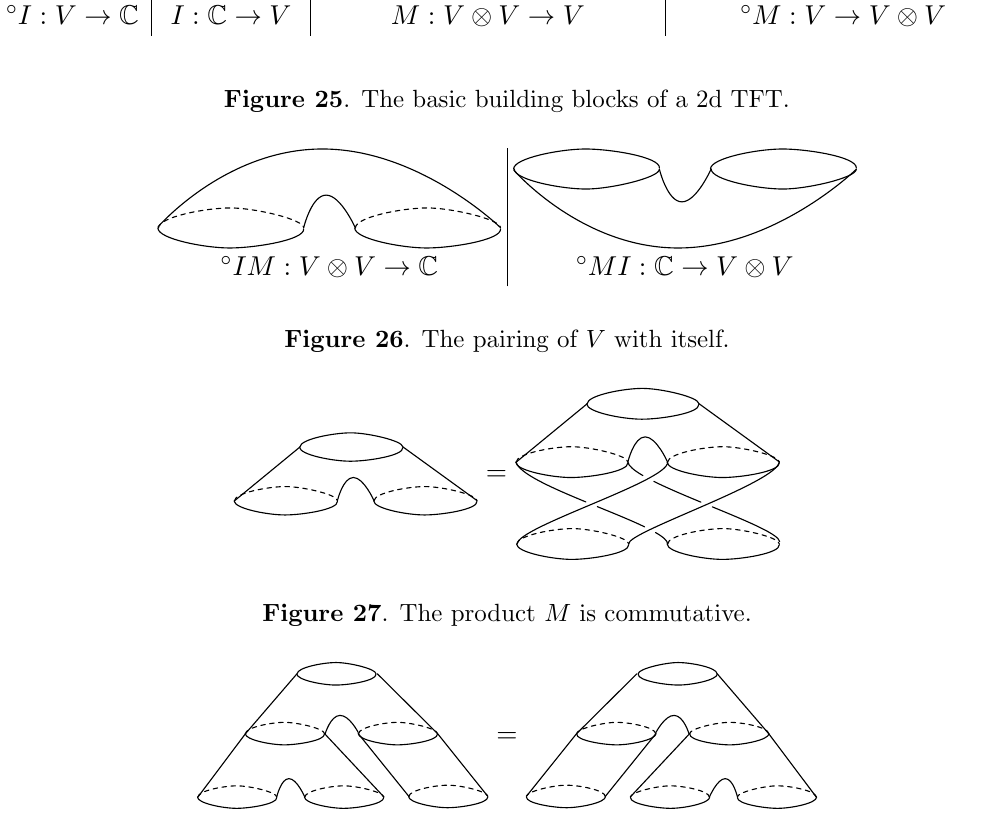
Figure 28 . The product M is